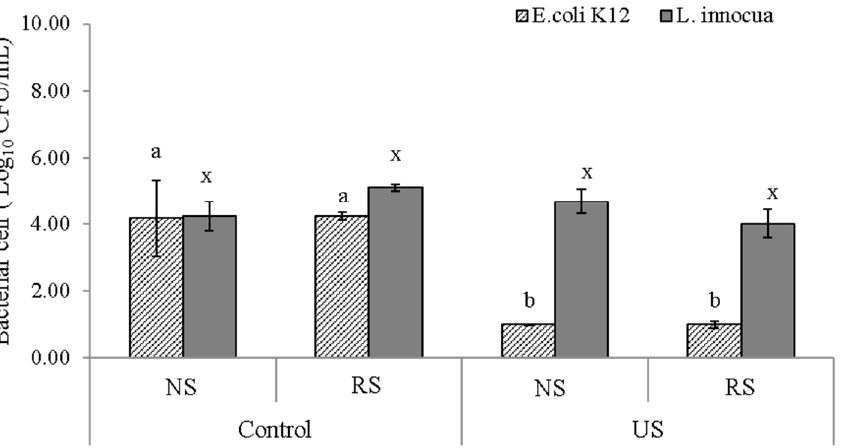
Figure 6. Bacterial inactivation in brine; values represents means ± standard deviation (SD, N = 3) of the log 10 CFU/mL for E. coli and L. innocua present in NaCl or NaCl/KCl brines after the inoculated meat was processed with (US) or without ultrasound (Control) for 1 and 4 h, respectively. Different letters represent significant differences at p < 0.05. In meat samples brined with US, a significant reduction of 4 log 10 CFU/mL ( p = 0.005)